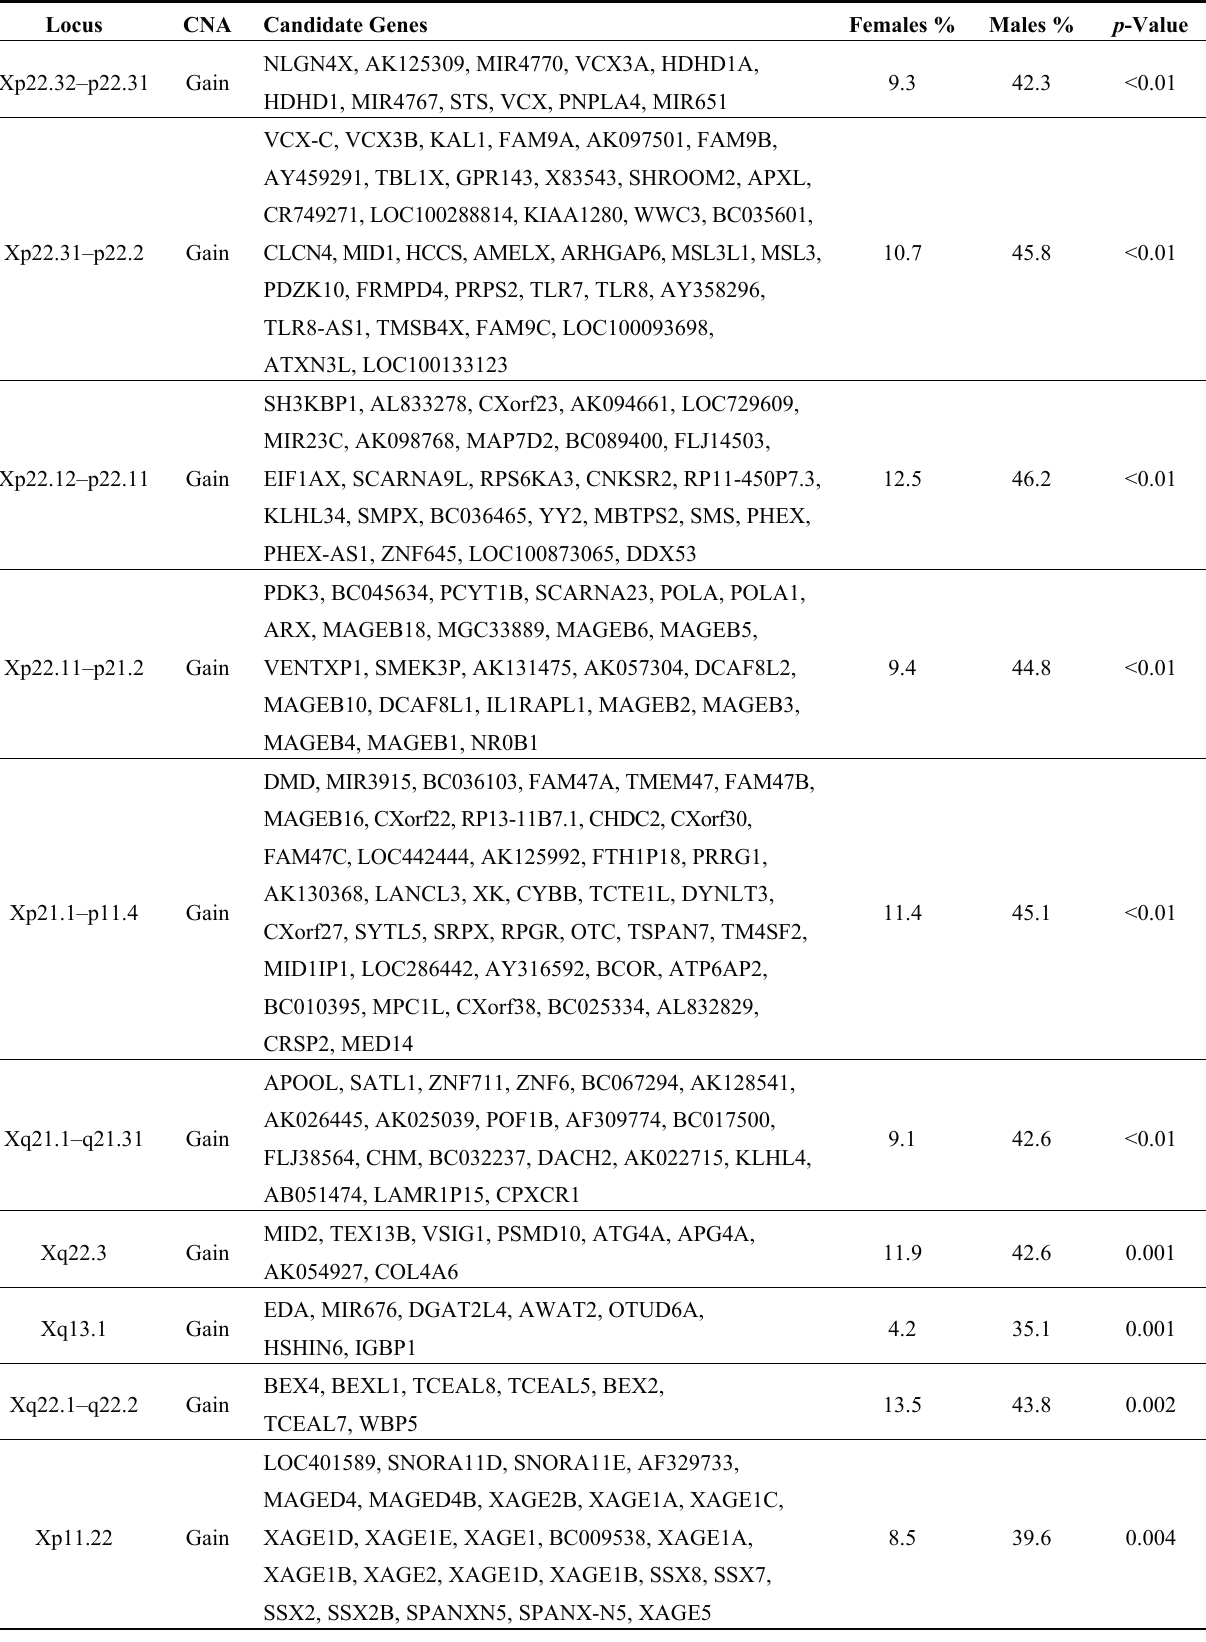
Table 3. Copy number aberrations involving sex chromosomes in male and female colorectal cancers by array comparative genomic hybridization. Locus CNA Candidate